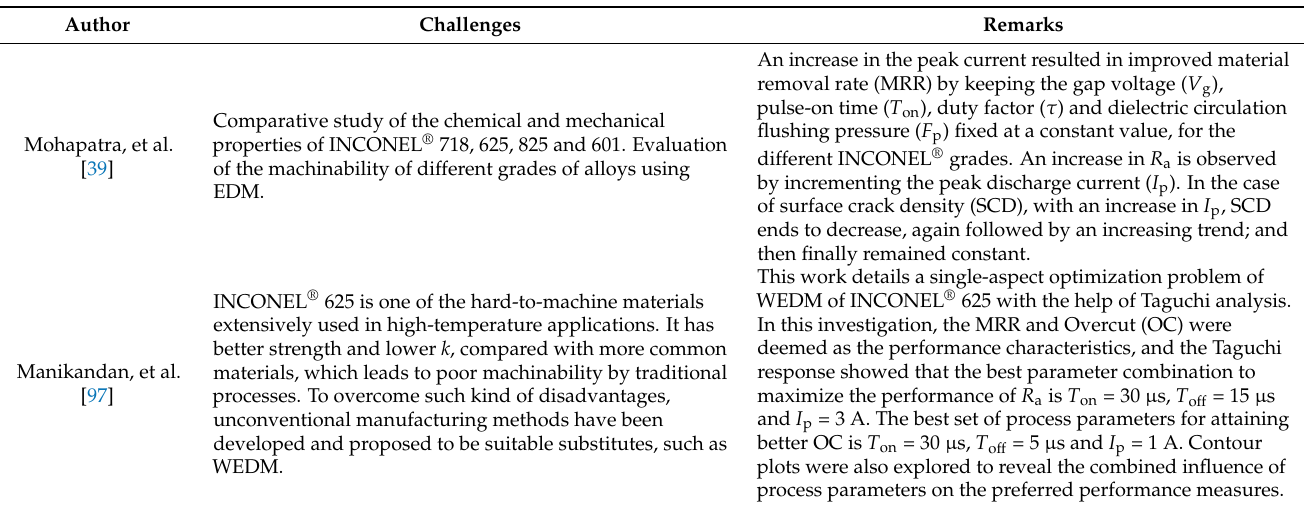
Table 9. Critical challenges and developments in the EDM process of INCONEL ®